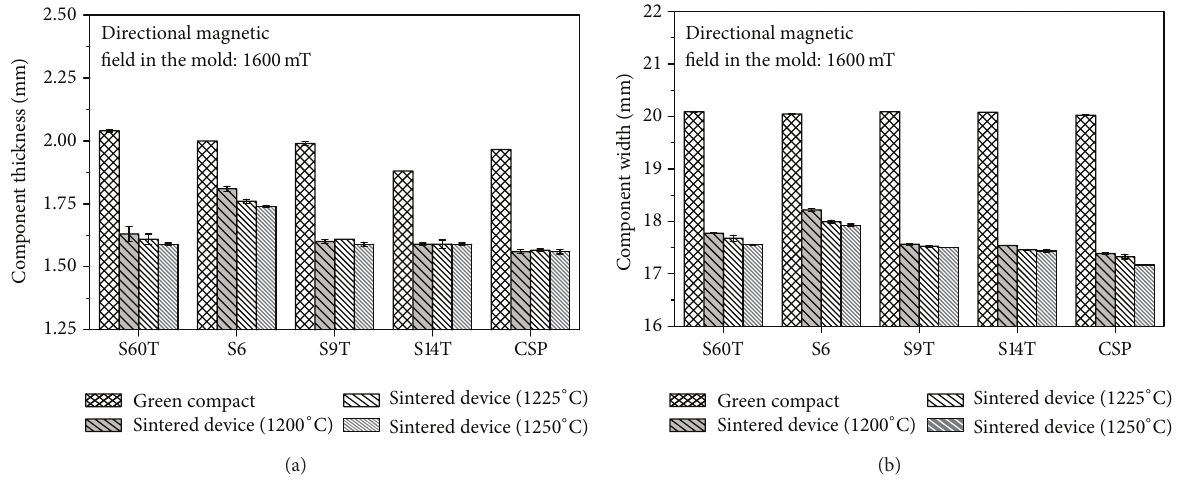
Figure 9: Shrinkage of sintered devices resulting from different sintering temperatures and powders.